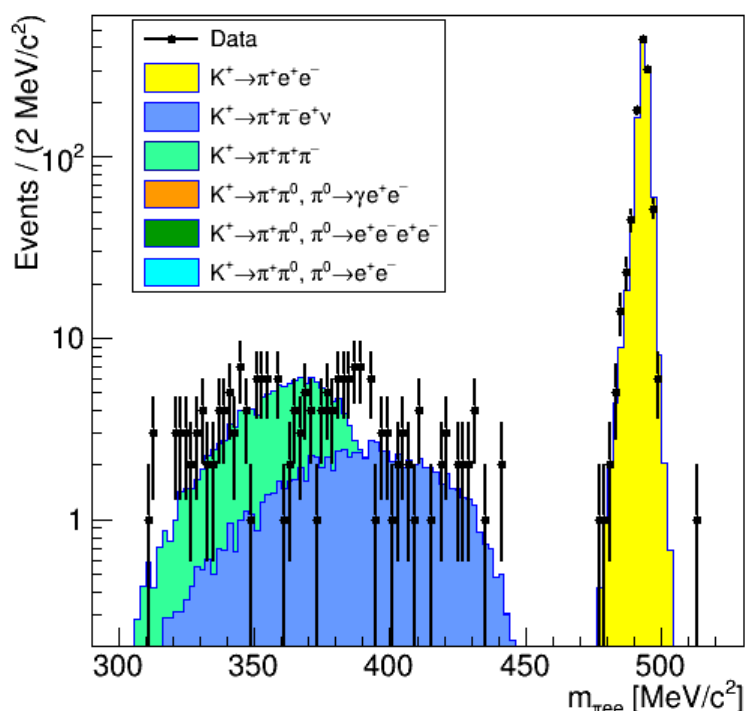
Figure 8. Reconstructed mass distribution of K + → π + e + e − candidates in the background-free region m ee > 140 MeV/c 2 ; data and MCestimates of various processes are visible [15].